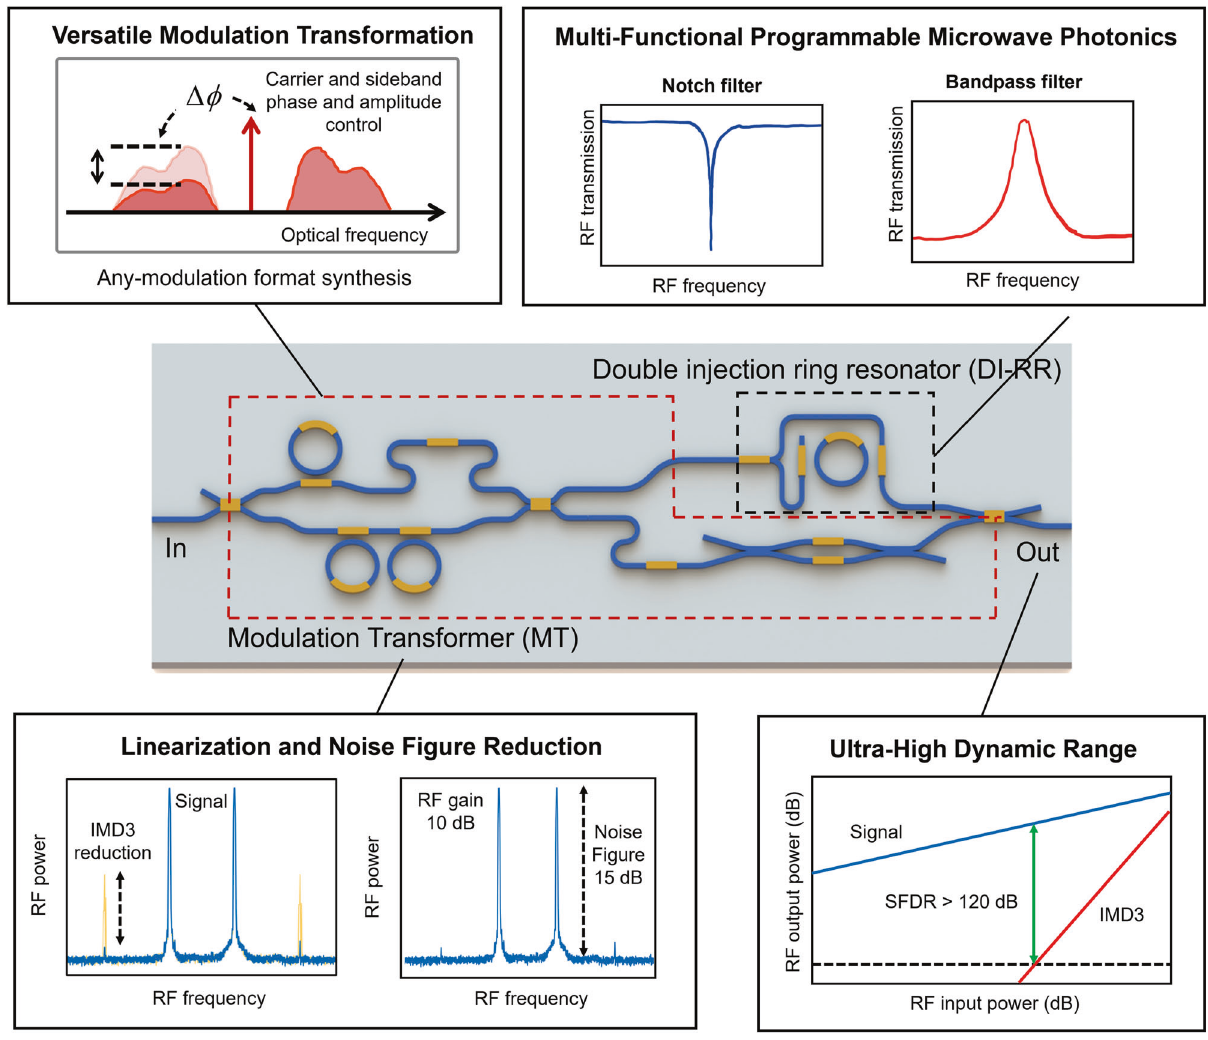
Fig. 1 | Artistic impression of an ultra-high dynamic range programmable integrated MWP circuit. The circuit contains of a versatile modulation transfor- mer (MT) to independently tailor the phase and amplitude of optical modulation spectrum and an equally versatile double-injection ring resonator (DI-RR) to syn- thesizeavarietyofresponses,includingprogrammableRF fi lters.Thecombination